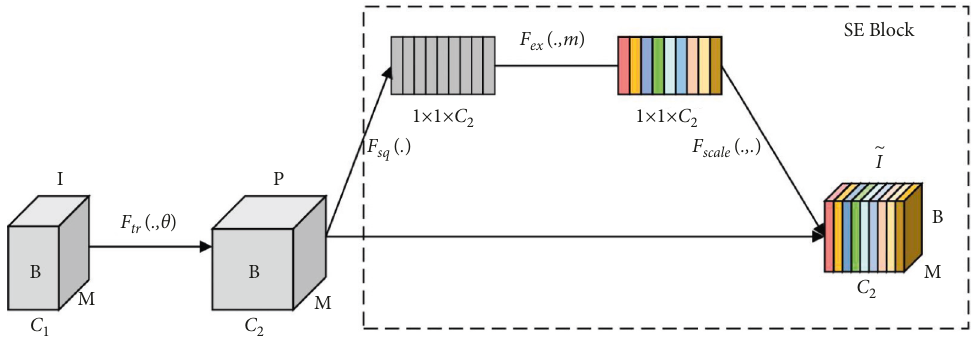
Figure 3: Structure of SENet module.